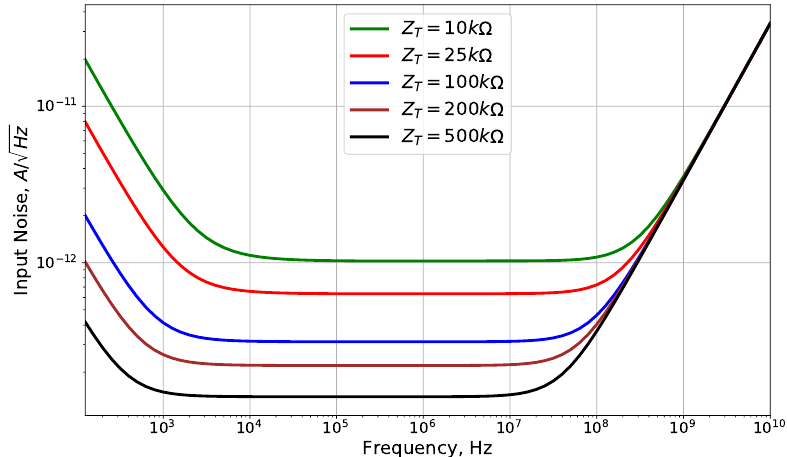
Figure 5. Analytically calculated input-referred noise model for programmable-gain configuration with M 1 thermal noise component and noises due to R bias,1 and R 2 (example case for TSMC 0.18 µ m